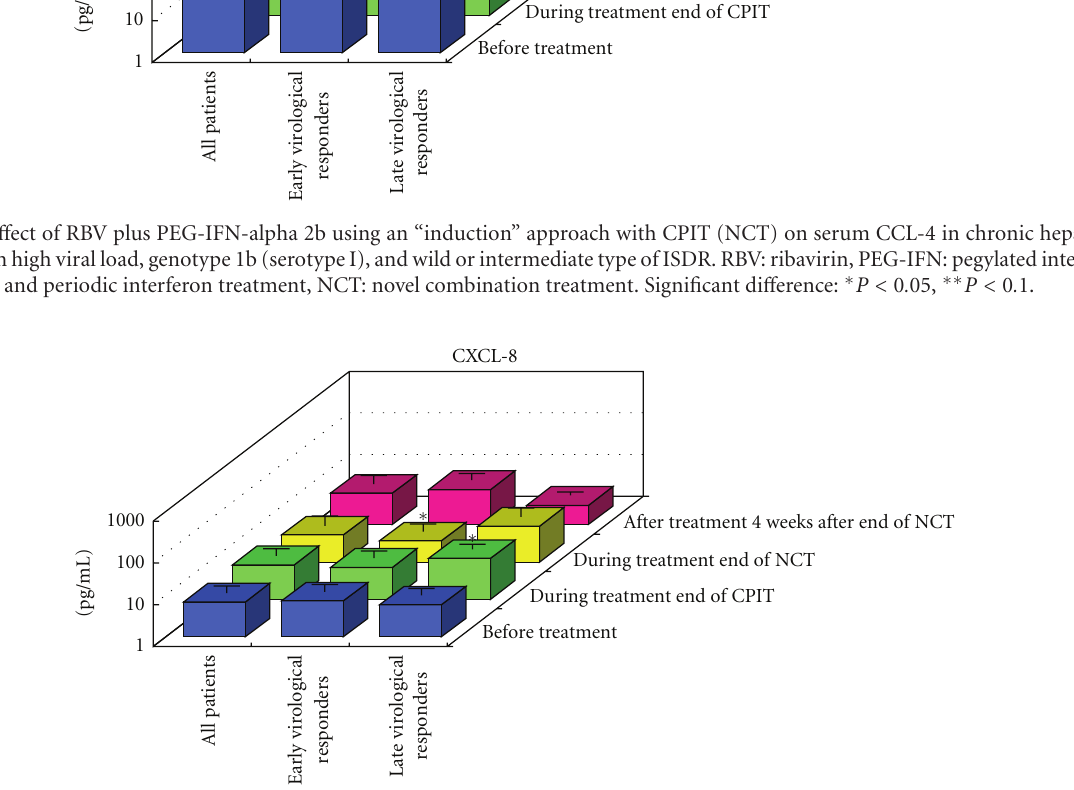
Figure 6: E ff ect of RBV plus PEG-IFN-alpha 2b using an “induction” approach with CPIT (NCT) on serum CXCL-8 in chronic hepatitis C patients with high viral load, genotype 1b (serotype I), and wild or intermediate type of ISDR. RBV: ribavirin, PEG-IFN: pegylated interferon, CPIT: cyclic and periodic interferon treatment, NCT: novel combination treatment. Significant di ff erence: ∗ P < 0 . 05, ∗∗ P < 0 .